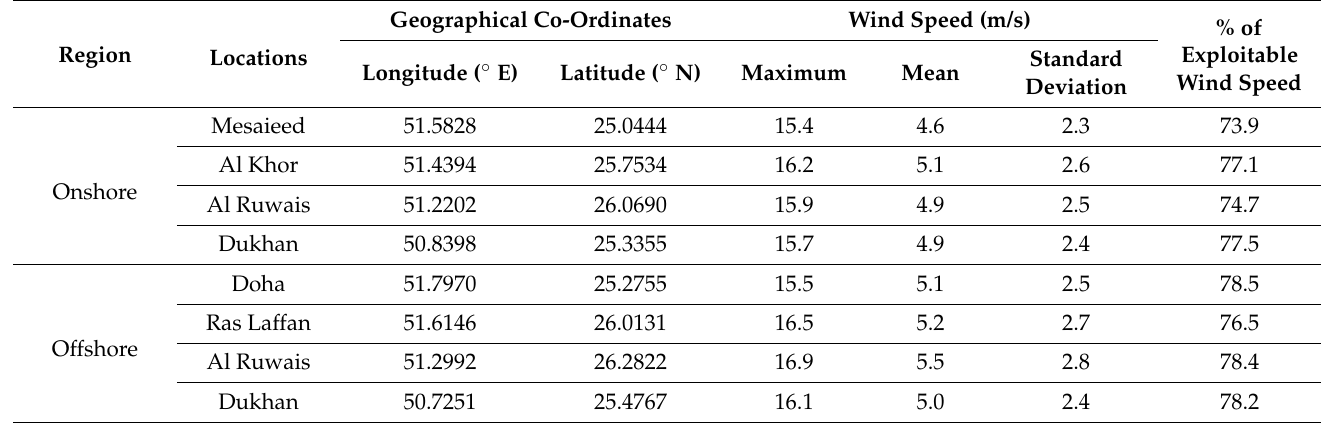
Table 1. Wind speed statistics at onshore and offshore locations from 1979 to 2018